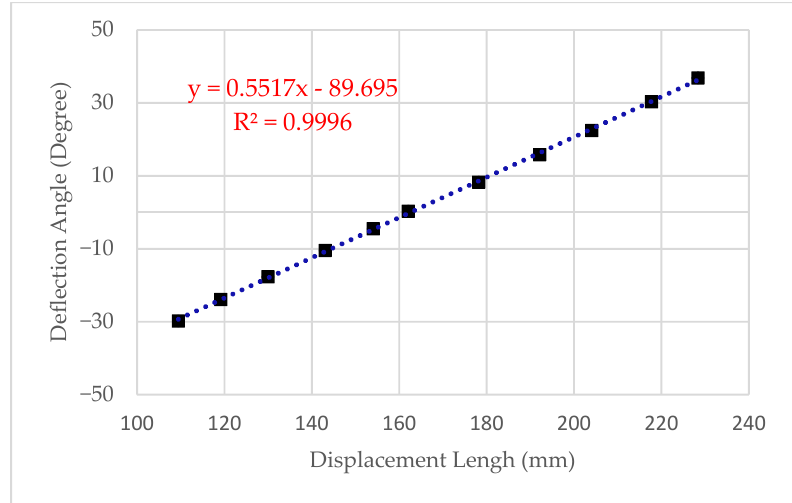
Figure 15. The relationship between the displacement length of the piston rod and the deflection angle of the wheel.